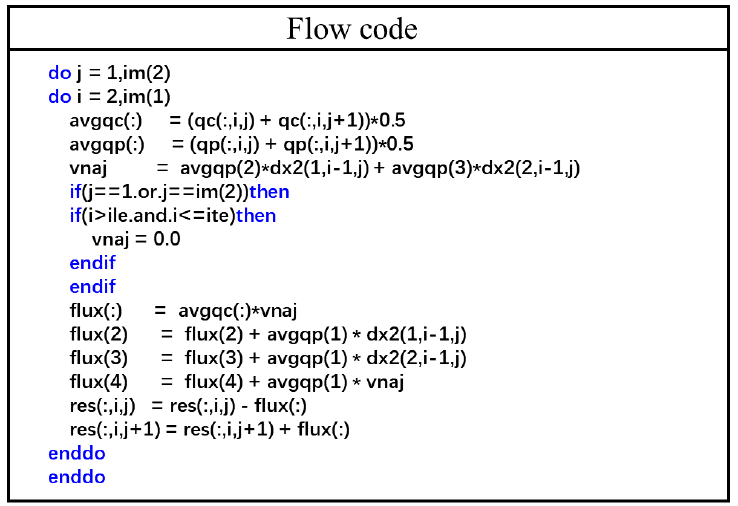
Figure 5. The flow codes corresponding to the calculation of convective